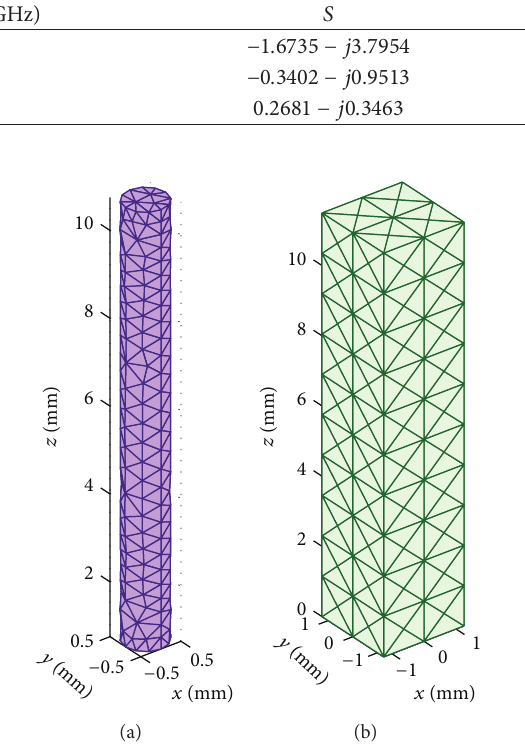
Figure 9: Microplasma rods: forward and backward RCS (along the 𝑥 -direction) as a function of the number of rows (each is comprised of 20 plasma rods) for three values of frequency. Remark: themarkersarejoinedwithdottedlinesforvisualization’ssake. Data : ) V/m, 𝑓 ∈ {10,20, 30} GHz, and 𝑑 = 2.5 mm E 𝑖 = ̂ z exp (−𝑗2𝜋𝑓𝑥/𝑐 0 (lattice constant and bricks’